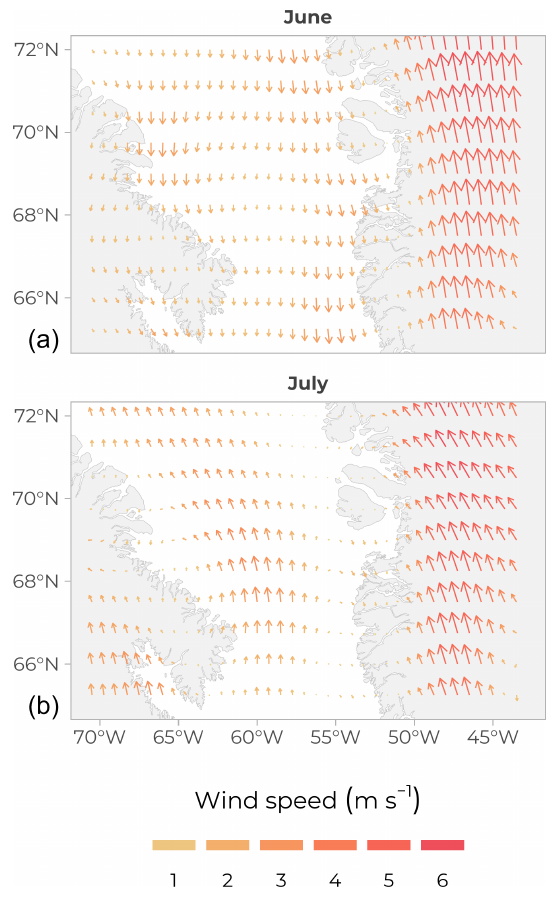
Figure 5. Average wind direction and speed (arrow length and colour) over Baffin Bay in June 2016 (a) and July 2016 (b) ; CCMP wind vector analysis product (V2.0, Atlas et al.,